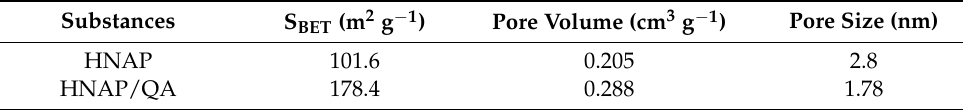
Table 1. Surface area and porosity of HNAP and HNAP/QA.